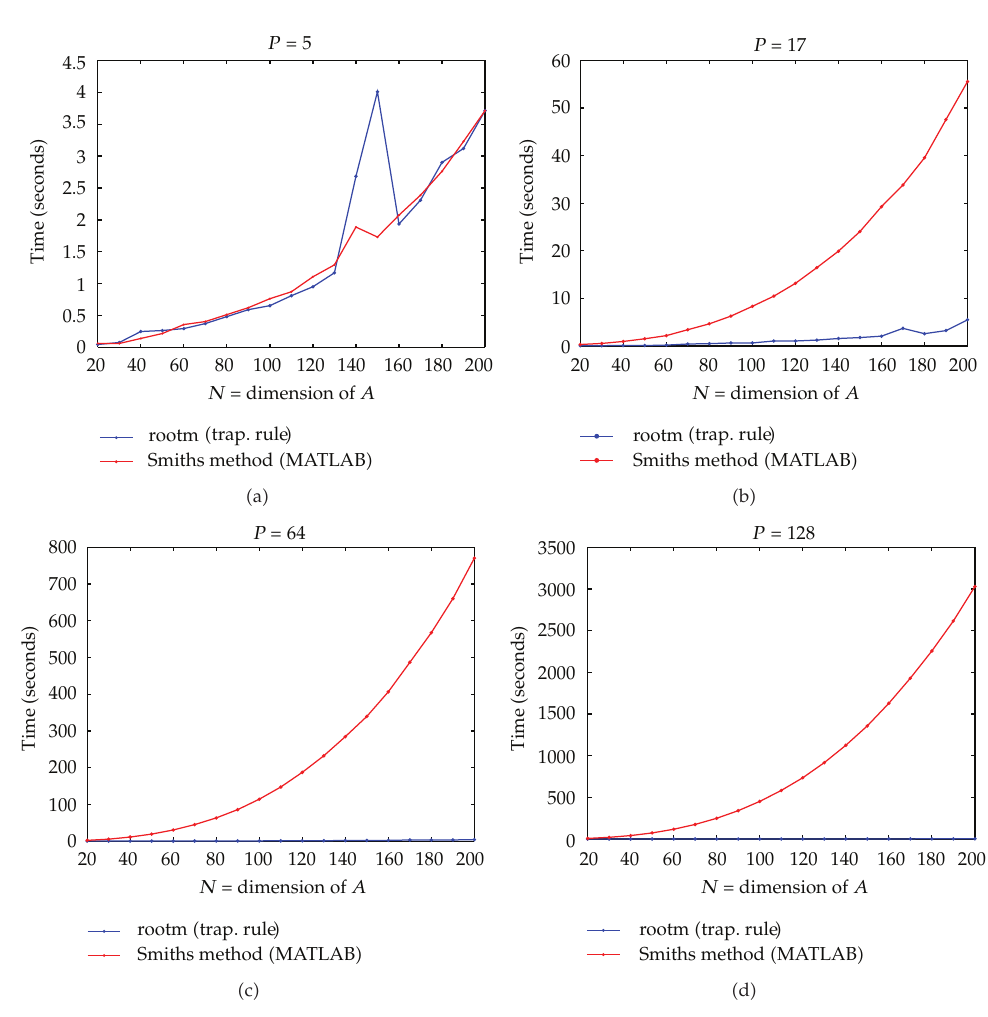
Figure 5: Time in seconds for computing A 1 /p for Hilbert